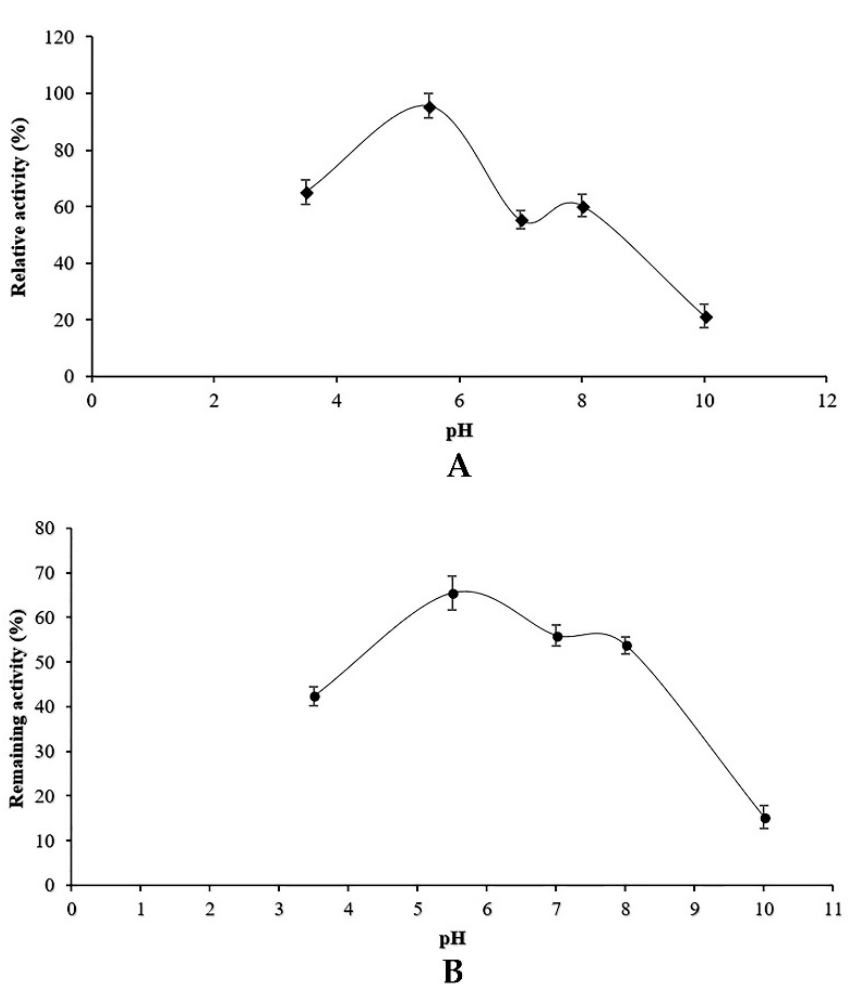
Figure 4. Effect of pH on the activity ( A ) and the stability ( B ) of the proteolytic enzymes of Penicillium bilaiae .